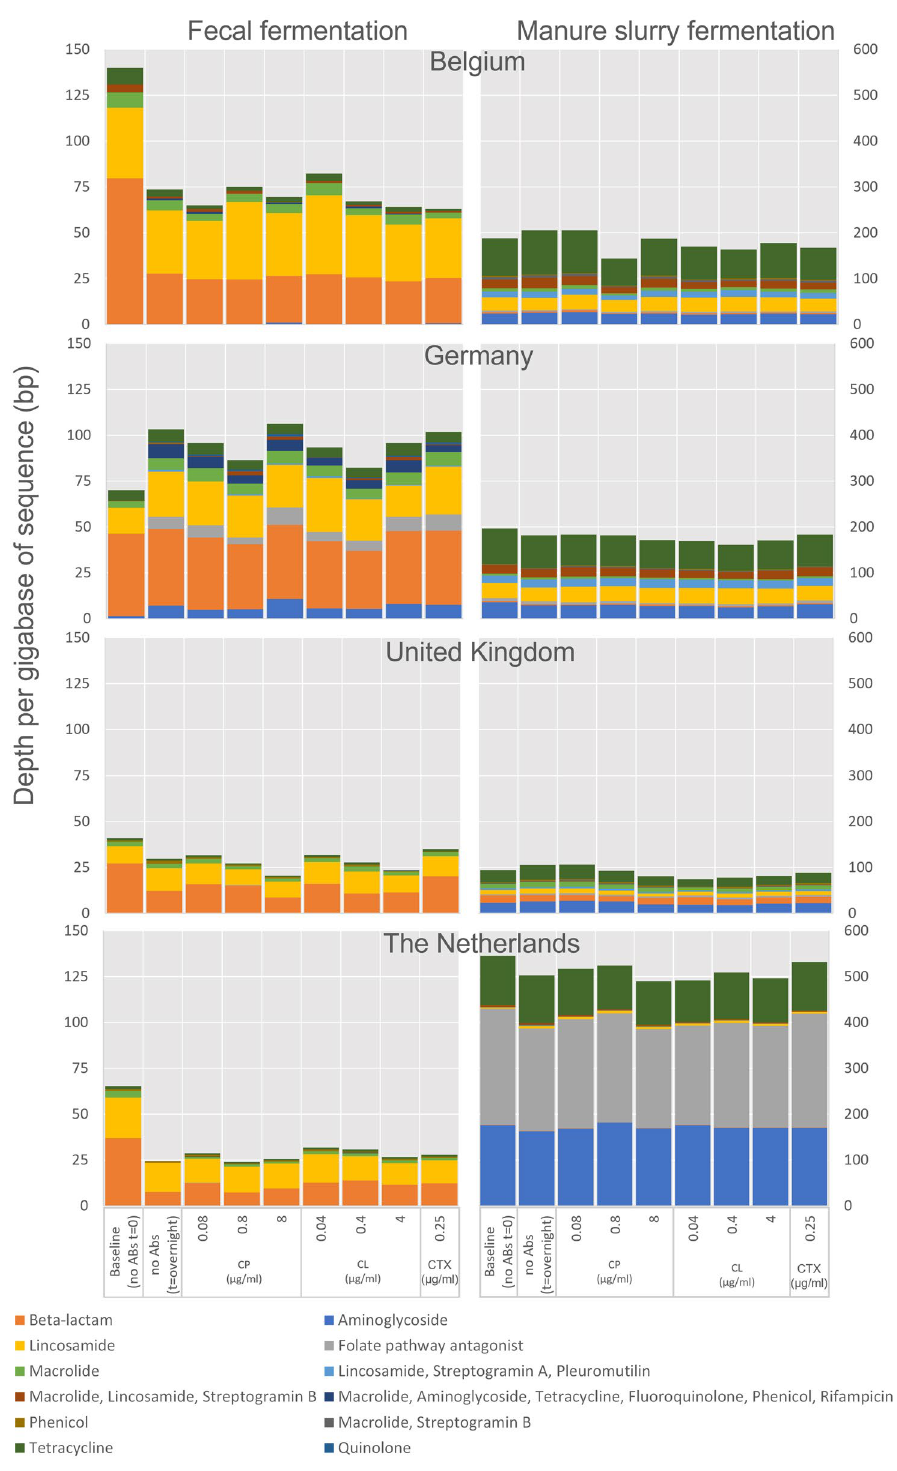
Figure 2. Allignments to resistance genes summed in the fecal fermentations and in manure slurry in the baseline samples, blank samples without antibiotics and per different concentrations of CP, CL and CTX for the four individual countries Belgium (BEL), Germany (GER), the United Kingdom (UK) and the Netherlands